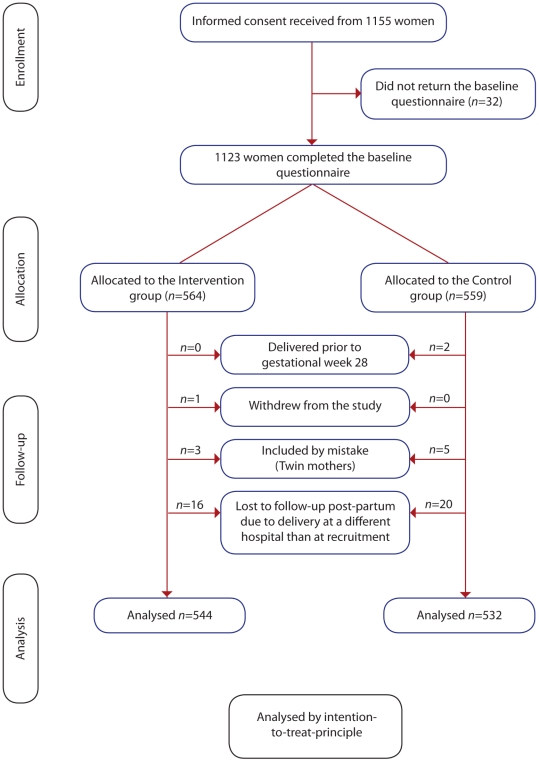
Flow chart study participants.